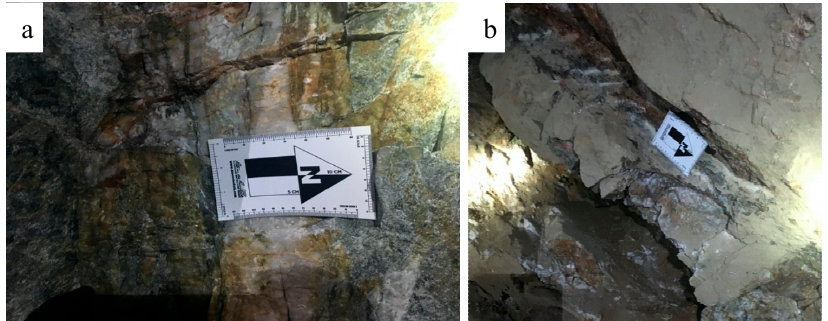
Figure 2. Quartz-calcite veins. ( a ) San Juan vein located in the sulfide zone in San Juan de Chorunga deposit; ( b ) Virucha vein located in the oxide zone in Mollehuaca deposit.